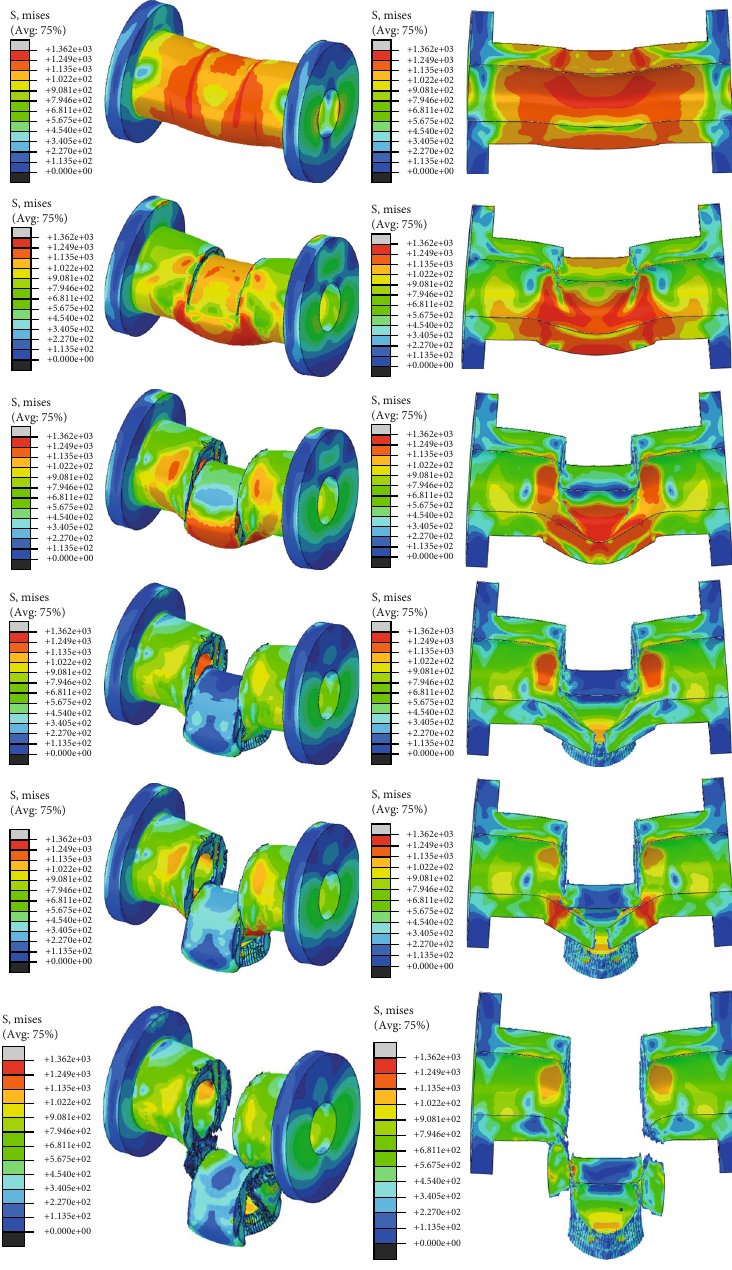
Figure 7: Fracture process of shear pins with di ff erent inner